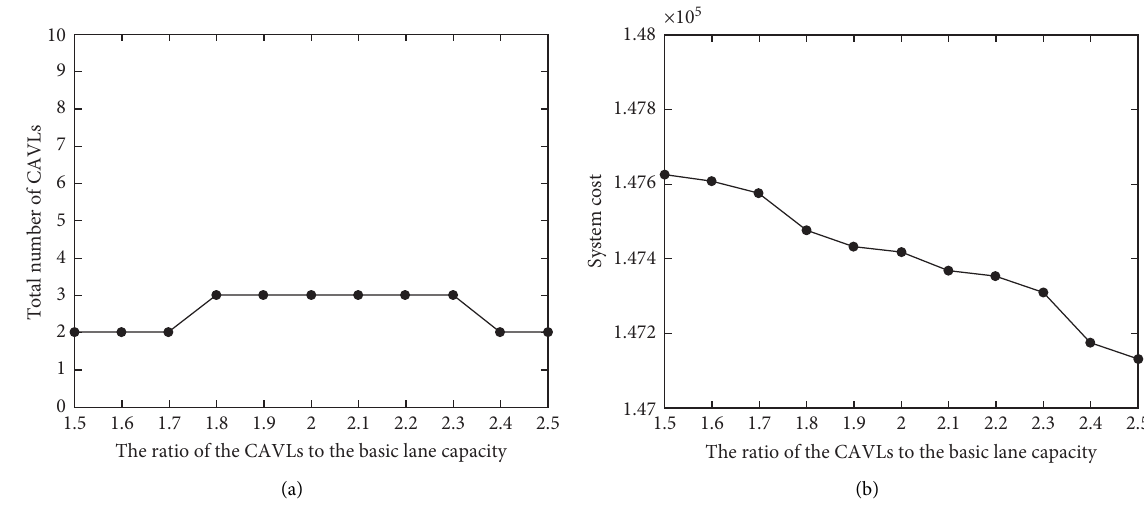
Figure 6: Sensitivity analysis of the capacity of CAVLs. (a) The total number of CAVLs. (b) System cost.